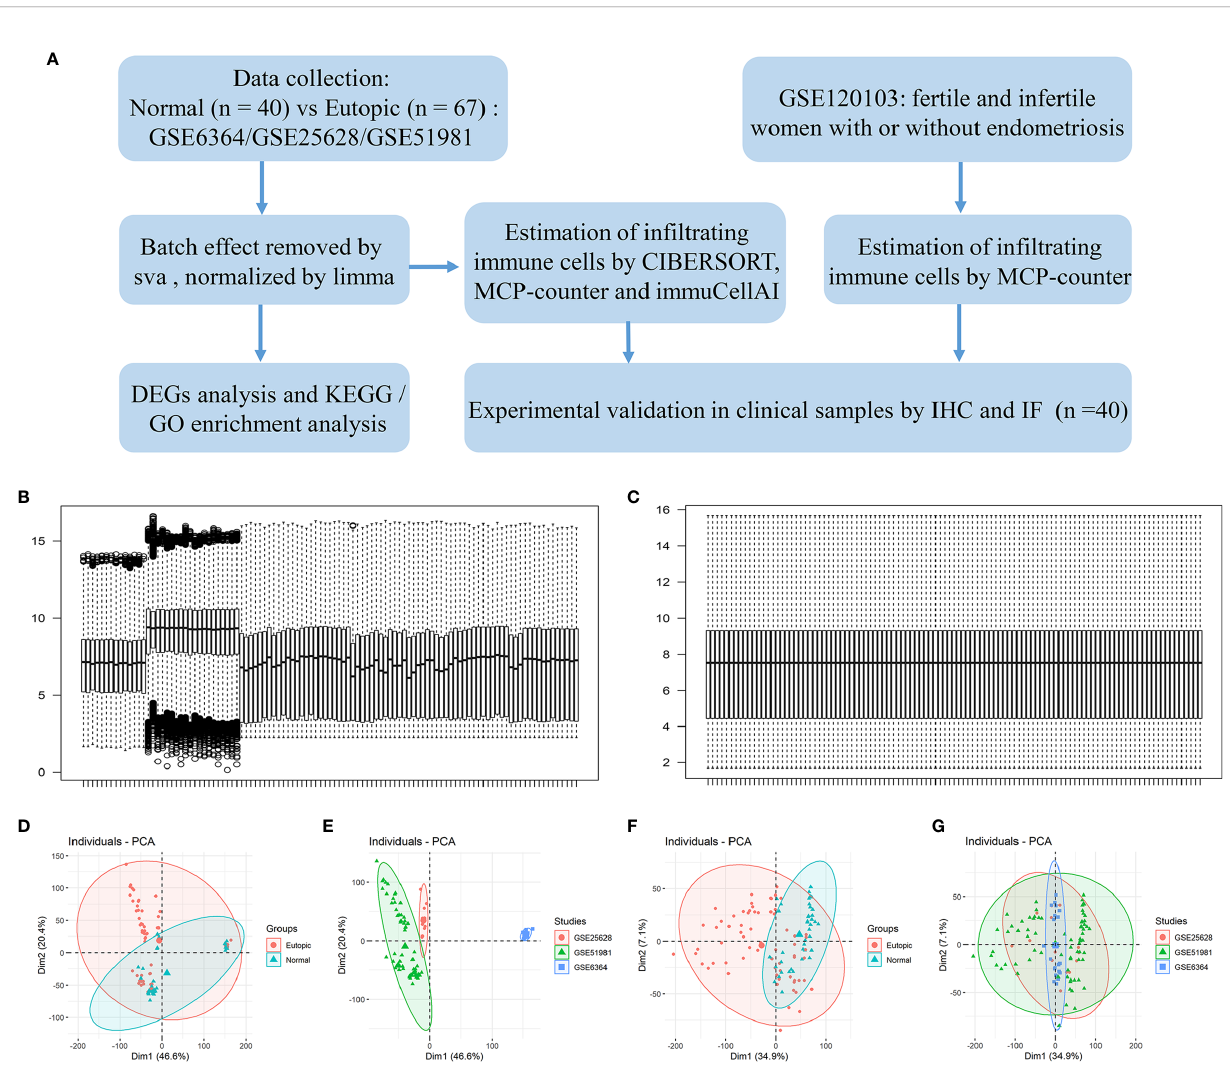
FIGURE 1 | The study fl owchart and gene expression after combining data from the datasets and identifying and removing the batch effect. (A) The study fl owchart. (B, C) Boxplots show the intensity of the log2-transformed gene expression before (B) and after (C) batch effect removal. (D – G) Scatter plots show the principal component analysis (PCA) analysis of normalized gene expression data before (D, E) and after (F, G) batch effect removal by Combat. Ellipses underlying assumptions about the distribution of the data were drawn considering a multivariate t-distribution and a con fi dence level of 0.95. GO, Gene Ontology; KEGG, Kyoto Encyclopedia of Genes and Genomes; DEGs, differentially expressed genes. IHC, immunohistochemistry; IF, immuno fl